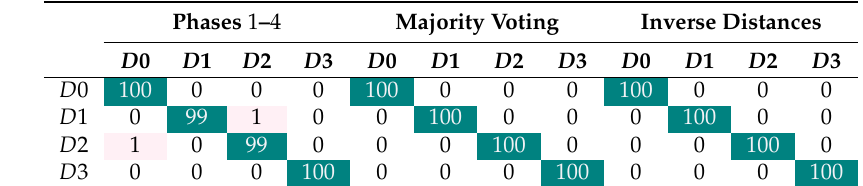
Table 2. Confusion matrix of the application of the t -SNE based damage detection and classification procedure presented in Sections 3 and 4 to the case of the aluminum plate in Scenario 1 , when the four actuation phases are used at the same time, in the frequency domain . Rows represent true values, while columns represent predicted values.